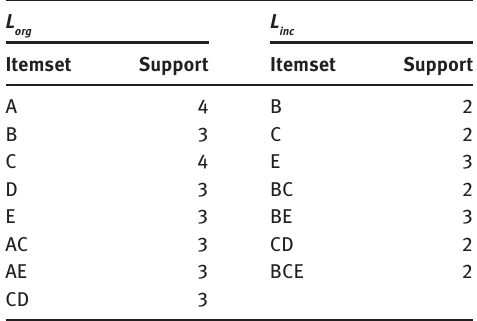
Table 7: Frequent Itemsets in Case 1.